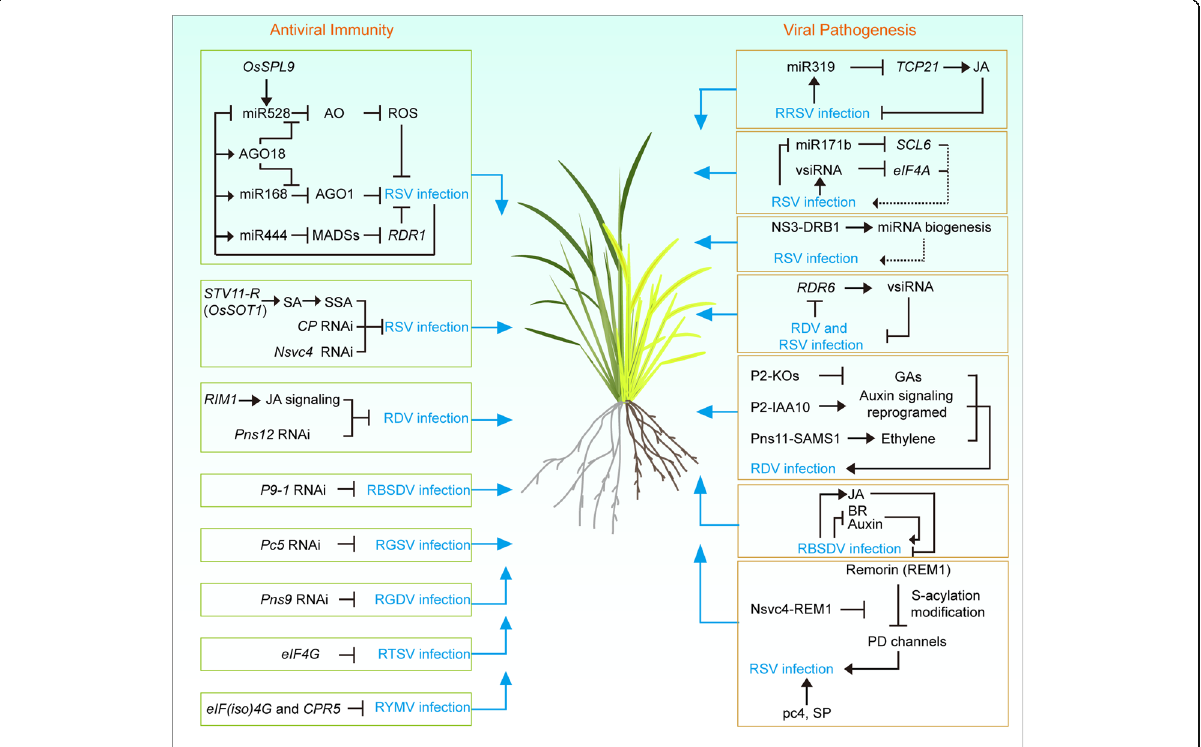
Fig. 2 Mechanisms of rice antiviral defense and viral pathogenesis. A simplified representation of the mechanisms behind rice and viruses ago- old battle involving RNA silencing pathway, phytohormone pathway, recessive resistance genes pathway and a subset of miRNAs. The left and right-half plane indicate an overview of different approaches used in rice for antiviral immunity and virial pathogenesis, respectively. Details present in the paper. Note that arrows and lines with bars indicate positive and negative regulatory actions, respectively. RBSDV, Rice black- streaked dwarf virus ; RDV, Rice dwarf virus ; RGDV, Rice gall dwarf virus ; RGSV, Rice grassy stunt virus ; RRSV, Rice ragged stunt virus ; RSV, Rice stripe virus ; RTSV, Rice tungro spherical virus ; RYMV, Rice yellow mottle virus ; BR, brassinosteroid; GA, gibberellins; JA, jasmonic acid; SA, salicylic